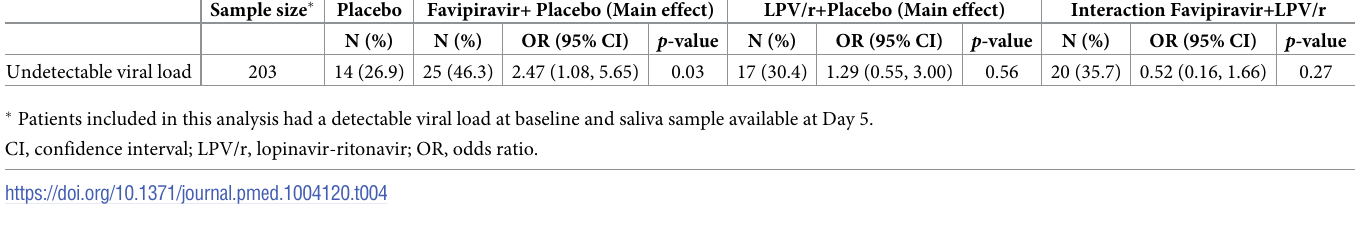
Table 4. Odds ratios of achieving undetectable viral load (Ct � 40) by Day 5. Sample size � Placebo Favipiravir+ Placebo (Main